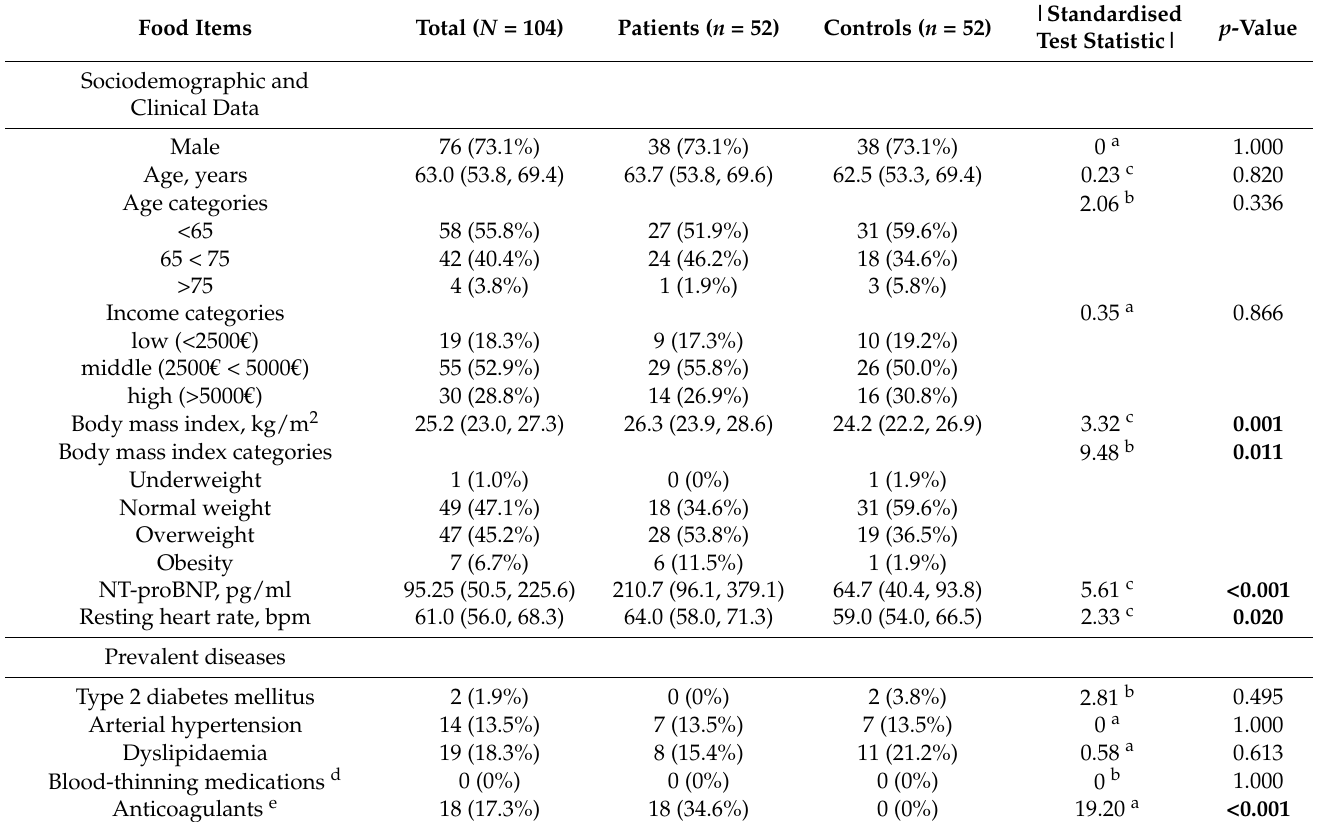
Table 1. Characteristics of study